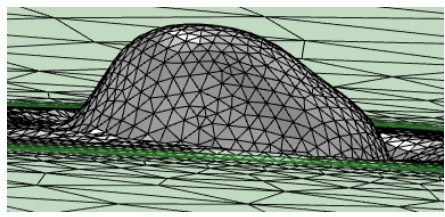
Figure 10. Ribbon formed during the interaction time of the laser beam.